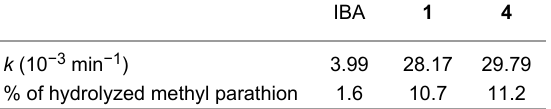
Table 2: Estimated pseudo-first-order rate constant ( k ) and amount (%) of hydrolyzed methyl parathion over the first 4 minutes.